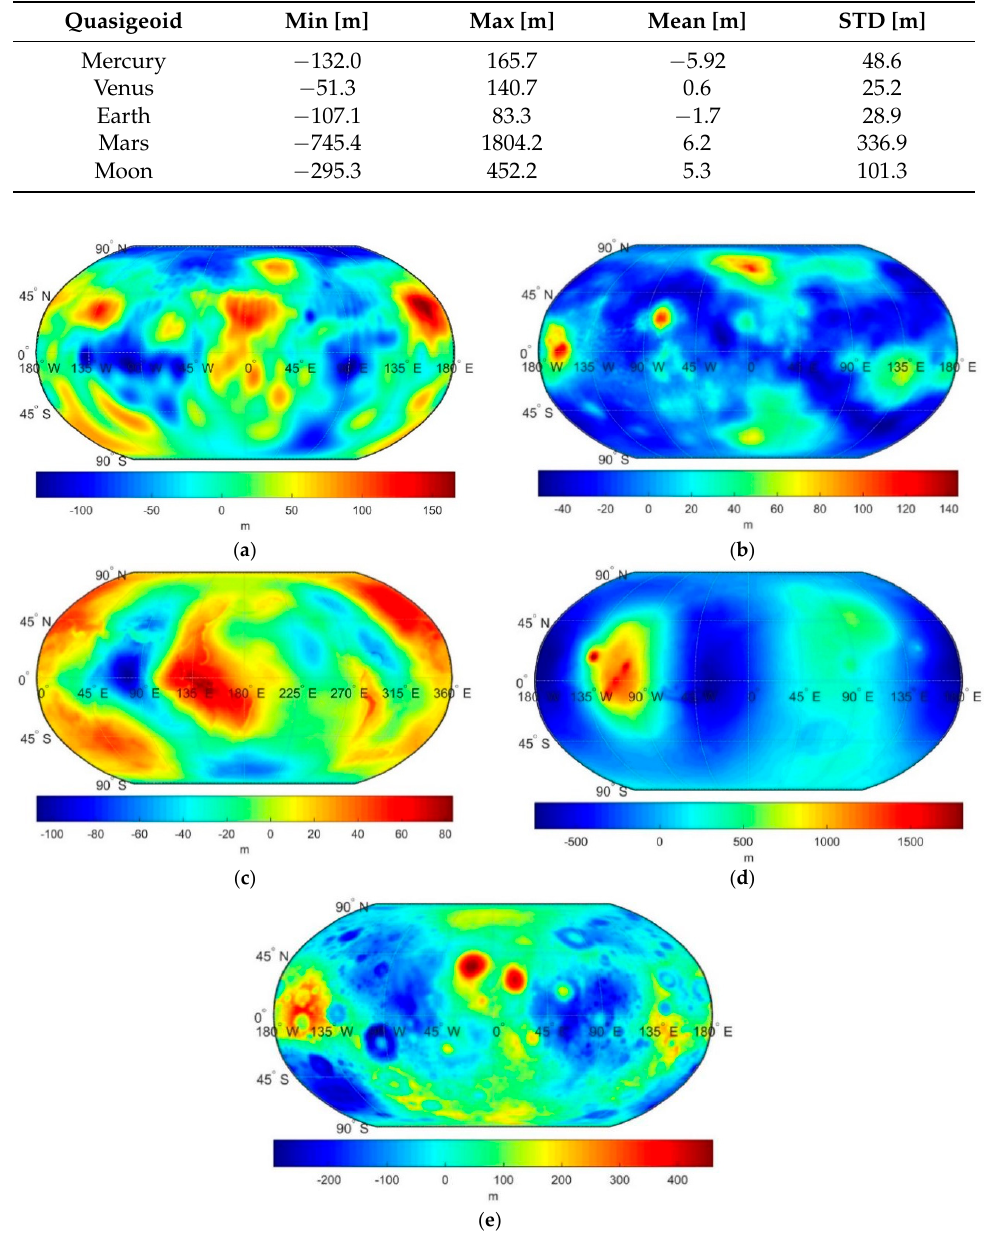
Figure 2. The quasigeoid models of ( a ) Mercury, ( b ) Venus, ( c ) Earth, ( d ) Mars and ( e ) the Moon. Except for some more detailed features, the global quasigeoid patterns on Mercury, Venus, Earth, Mars and the Moon (Figure 2) very closely agree with the geoid patterns on these planetary bodies as presented in Reference [9]. The quasigeoid undulations on Mercury are spatially correlated with major topographic features, having negative values typically in lowlands and positive values in